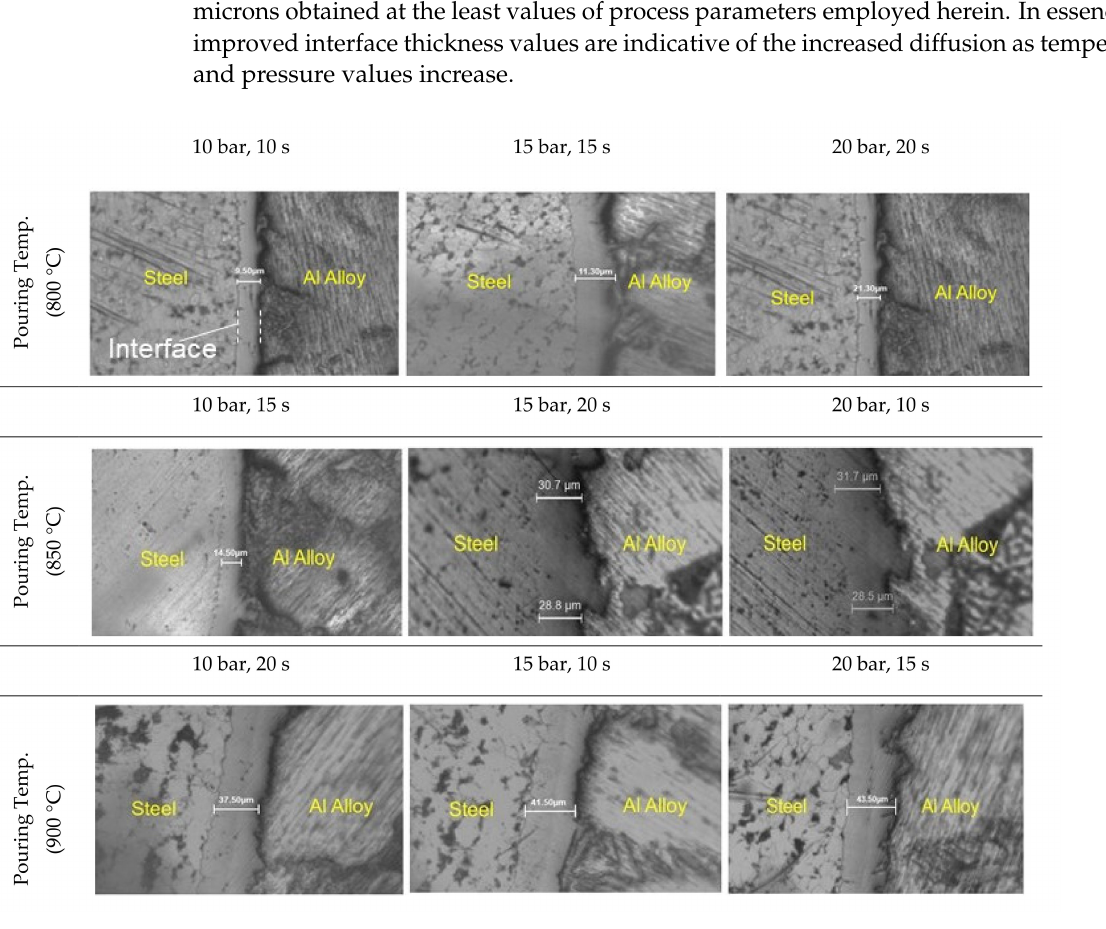
Figure 5. Microstructures of the interface region of bimetals made at different temperatures and